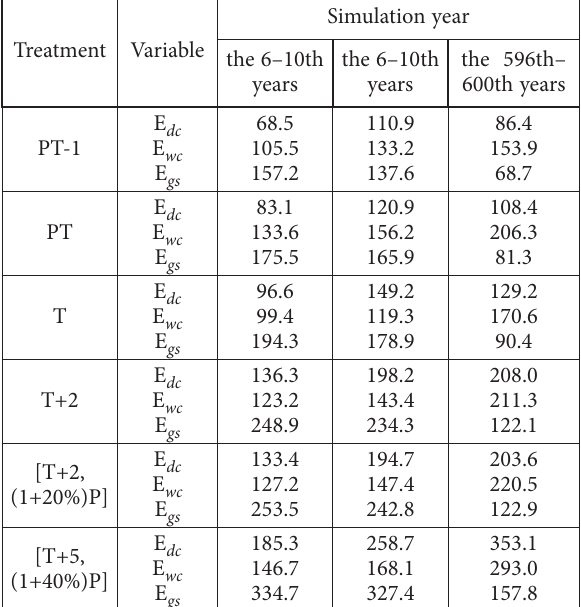
Table 3. Transpiration (E dc ), canopy interception evaporation (E wc ) and soil evaporation (E gs ) during the three periods